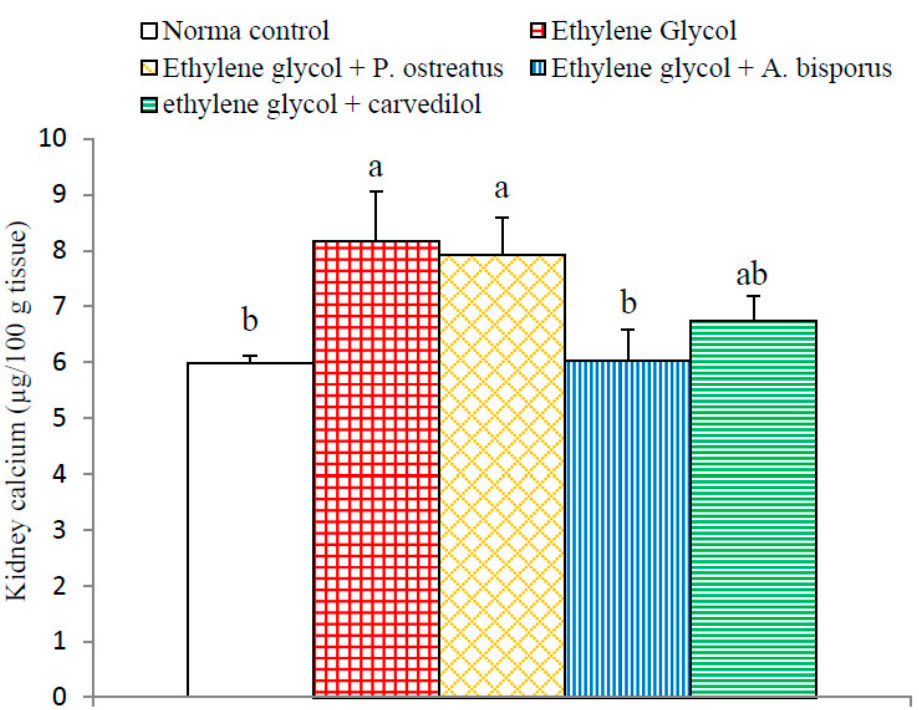
Figure 10. Effect of P. ostreatus and A. bisporus aqueous extracts and carvedilol on kidney calcium content in ethylene glycol-administered rats. Means which share the same letter(s) are not significantly different.